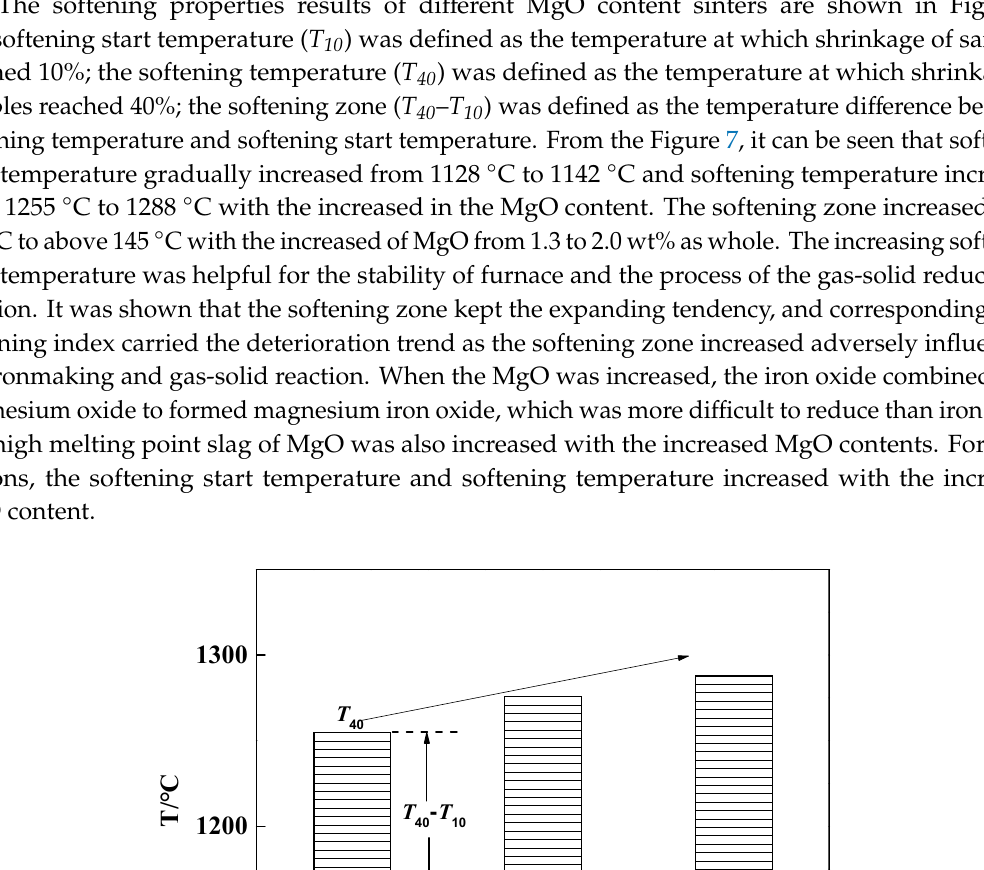
T D Figure 8. T S , T D and melting zone for different MgO content sinter. It was found that the melting temperatures were similar, 1291 °C with an MgO content of 1.3 wt% and 1312 °C with an MgO content of 2.0 wt%. The suitable melting temperature was helpful to the BF strengthening smelting. The dripping temperature increased from 1447 °C to 1519 °C when the MgO content increased from 1.3 to 2.0 wt%. However, the melting-dripping zone advanced rapidly to a relatively high value above 200 °C, indicating the worsening of the melting-dripping index. The location of the melting-dripping zone moved down and the territory became thicker with the increased MgO content. Therefore, the melting properties of sinter worsened with the increased MgO content. The results of dripping behavior of sinters with different MgO content are shown in Figure 9. The results indicate that the dripping iron was decreased, whereas the dripping slag was increased with increased MgO content in the sinter. The worse reduction of mixed burden and the generations of high melting point materials dispersed in the slag phase were the primary reasons for the decreased dripping iron.